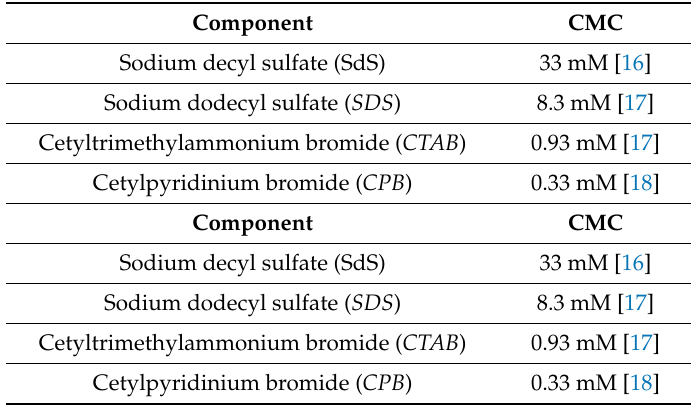
Table 1. Critical micellar concentrations (CMC) of the employed